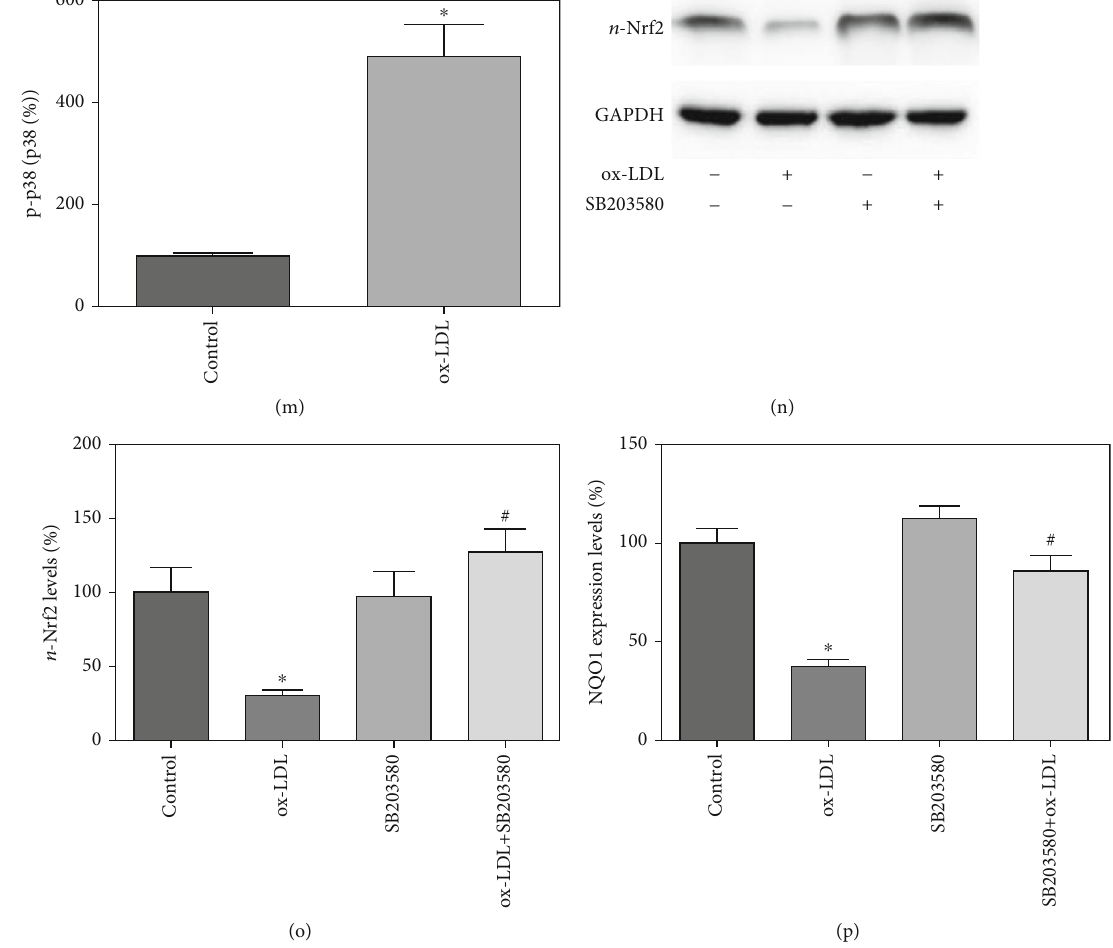
Figure 2: ox-LDL inhibited Nrf2 nuclear translocation via MAPK-p38 pathway. (a, b) EPCs were exposed to di ff erent concentration of ox- LDL (5-20 μ g/mL) for 24hours. The ratio of the control group was assigned a value of 1. Quanti fi cation of relative quantity of n-Nrf2/ Histone H3 and c-Nrf2/GAPDH showed that ox-LDL concentration dependently decreased n-Nrf2/Histone H3, but not signi fi cantly in fl uenced the c-Nrf2/GAPDH levels. (c, d) EPCs were transfected with speci fi c siRNA against Keap1 or silencer select negative control (control group) for 24 hours. Western blot detection showed that Keap1 expression level was signi fi cantly inhibited by Keap1 siRNA transfection. (e, f) The inhibition of Nrf2 nuclear translocation in response to ox-LDL was reversed by pretreatment with the Keap1 siRNA, as shown by Western blot. (g, h) ox-LDL time- and dose-dependently decreased NQO1 mRNA transcription. (i) Pretreatment with Keap1 siRNA reversed ox-LDL-induced downregulation of NQO1 mRNA transcription. (j, k) Pretreatment with Keap1 siRNA reversed ox-LDL-induced downregulation of NQO1 protein expression. (l, m) ox-LDL signi fi cantly increased p38 phosphorylation. (n, o) Treatment with 1 μ M SB203580, a speci fi c p38 inhibitor, reversed the ox-LDL-induced downregulation of Nrf2 nuclear translocation. (p) Pretreatment with SB203580 reversed ox-LDL-induced downregulation of NQO1 mRNA transcription. ∗ p < 0 : 01 vs. control. # p < 0 : 01 vs. ox-LDL